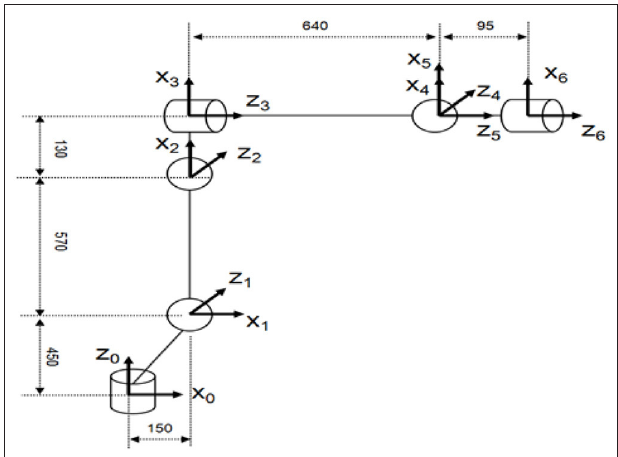
FIGURE 1 | The coordinate system of the 6-DOF manipulator.